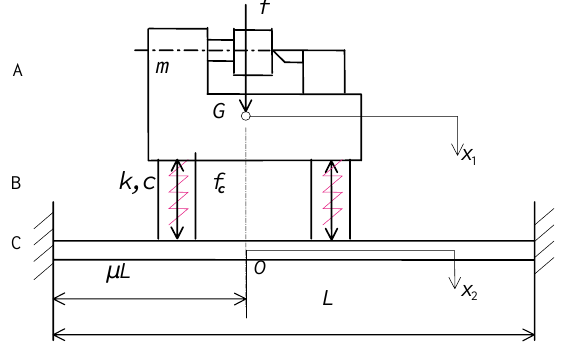
Fig. 1. Demonstration of a simple hybrid isolation system with active actuator in parallel with passive